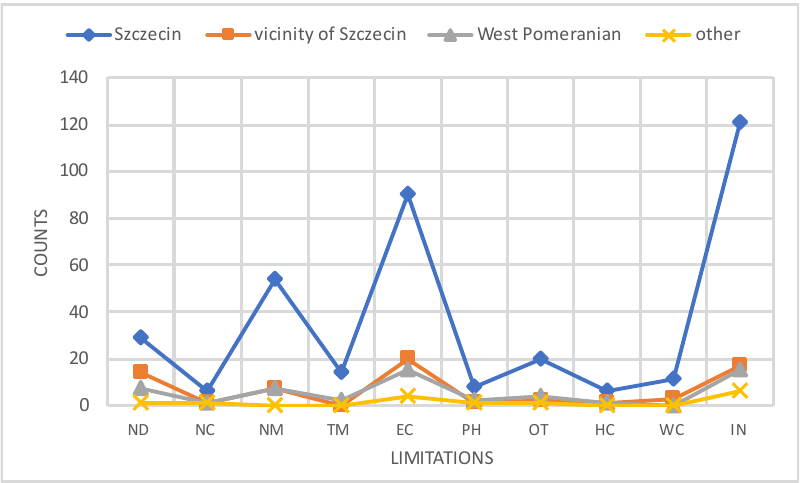
Figure 22. A graph of interaction between the limitations regarding car availability and the respondent’s place of residence.